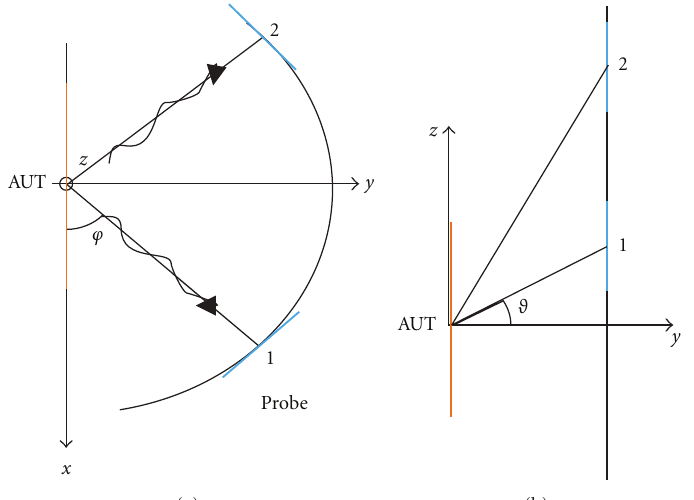
Figure 13: Illustrating the need for probe compensation. When the probe rotates around the AUT from position 1 to 2 (a), approximately the same receiving features of the probe are involved. When the probe moves along the z axis from position 1 to 2 (b), di ff erent receiving features of the probe become relevant.